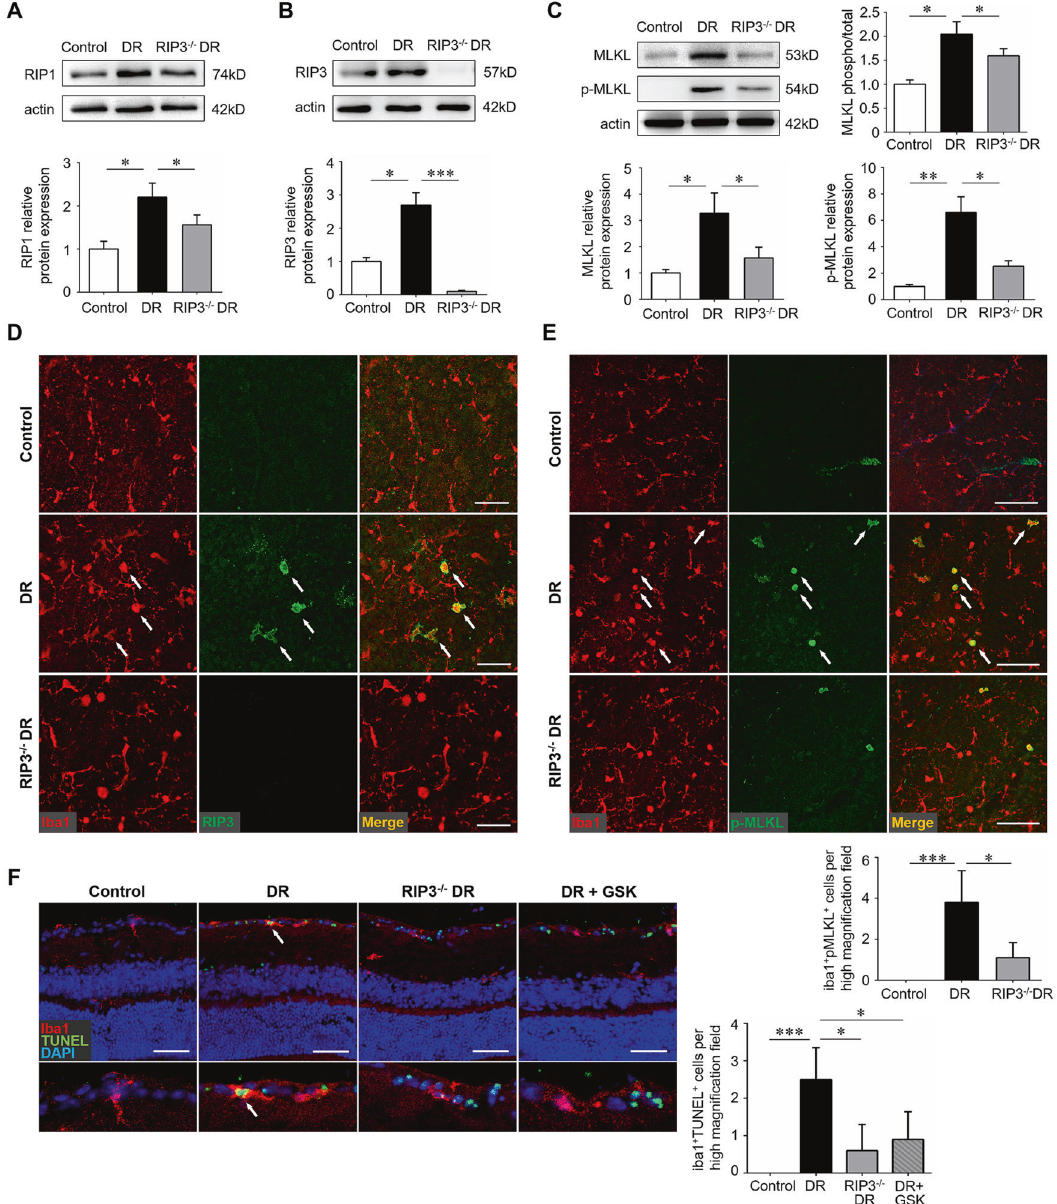
Fig. 3 RIP3 de fi ciency blocked the process of necroptosis in microglia. Wild-type C57BL/6 J and RIP3 − / − mice were used to create the streptozotocin-induced diabetes model and retinal samples were collected 12 weeks after diabetes induction. A , B The protein level of RIP1 and RIP3 was detected by western blotting. C The protein level of MLKL and p-MLKL were detected by western blotting. D Double immuno fl uorescence staining of iba1 and RIP3 on retinal fl at-mounts. Arrows indicated cells that were both iba1 and RIP3 positive. Scale bar: 50 μ m. E Double immuno fl uorescence staining of iba1 and p-MLKL on retinal fl at-mounts. Arrows indicated cells that were both iba1 and p-MLKL positive. Scale bar: 100 μ m. Three images were obtained in different locations of the retina (central, mid-peripheral and